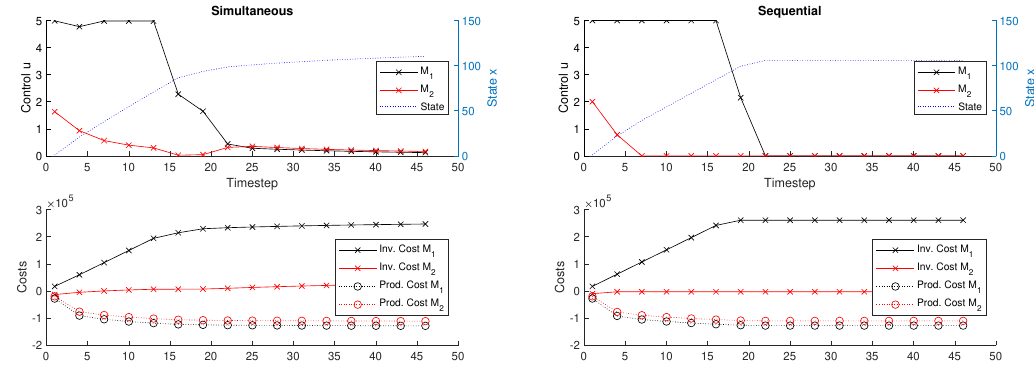
Figure 6. Supplier development schema for M 1 and M 2 in the simultaneous and sequential